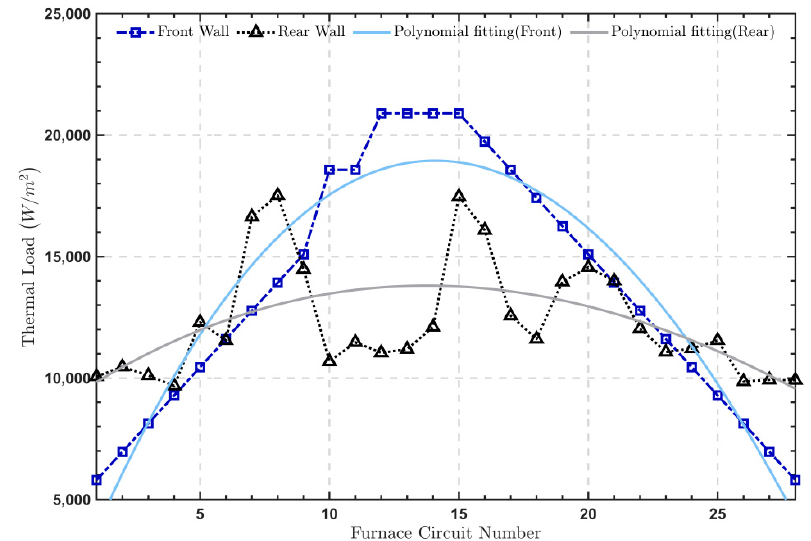
Figure 11. Average Thermal Load Distribution Along Height